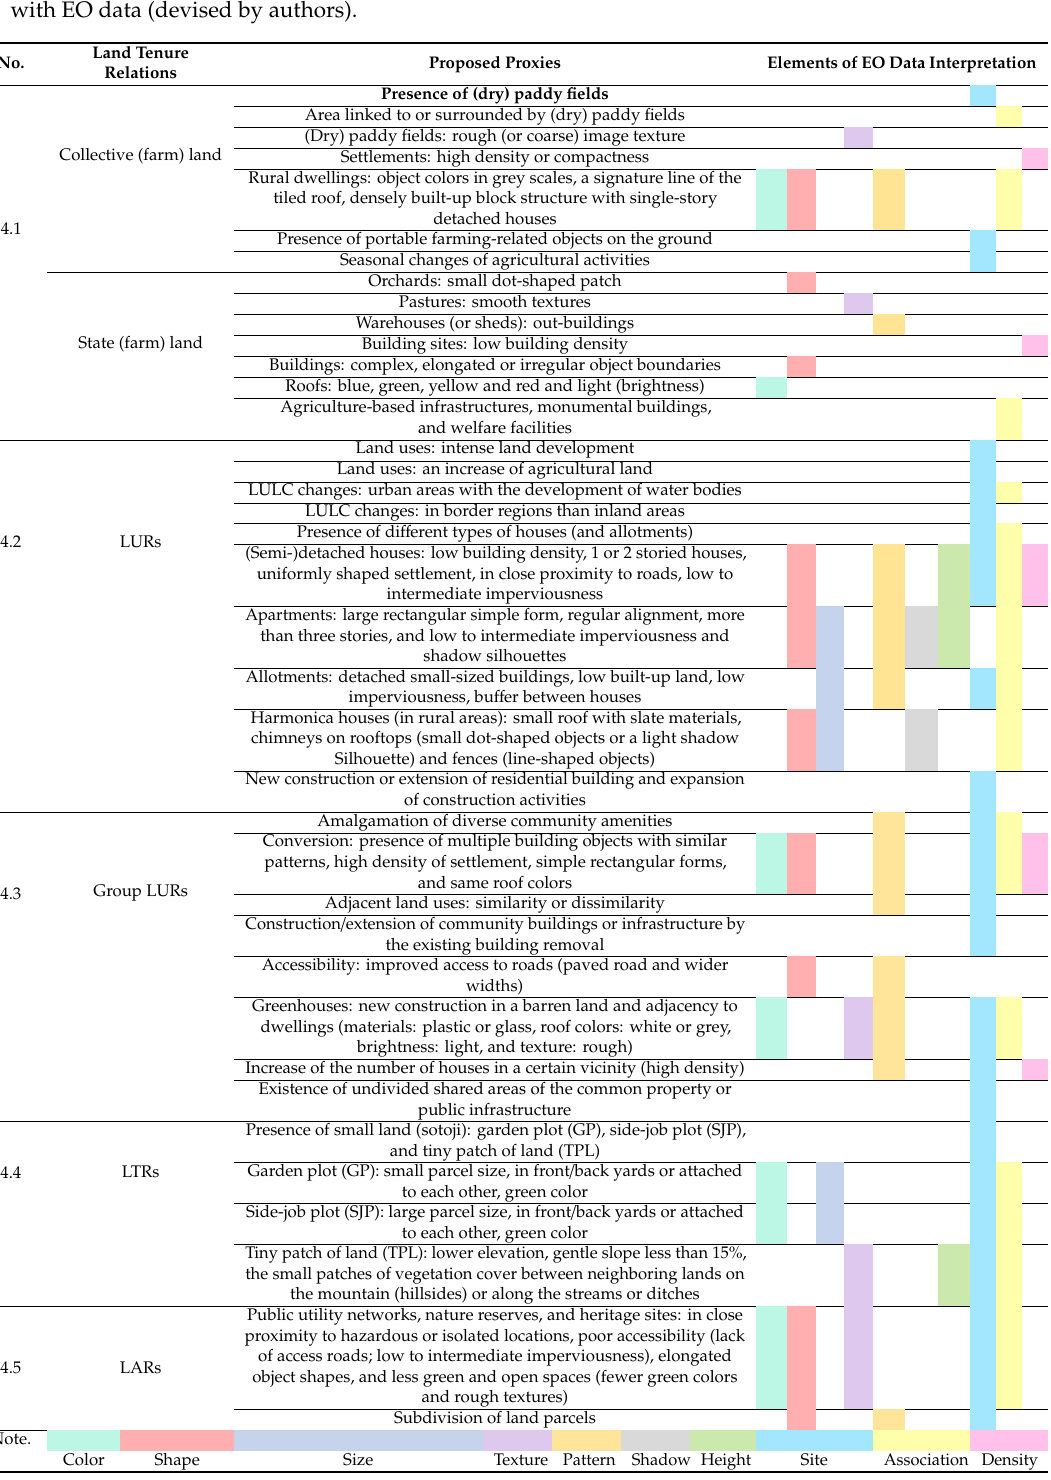
Table 4. Identifying proxies to derive unknown land tenure relations over North Korea in conjunction with EO data (devised by